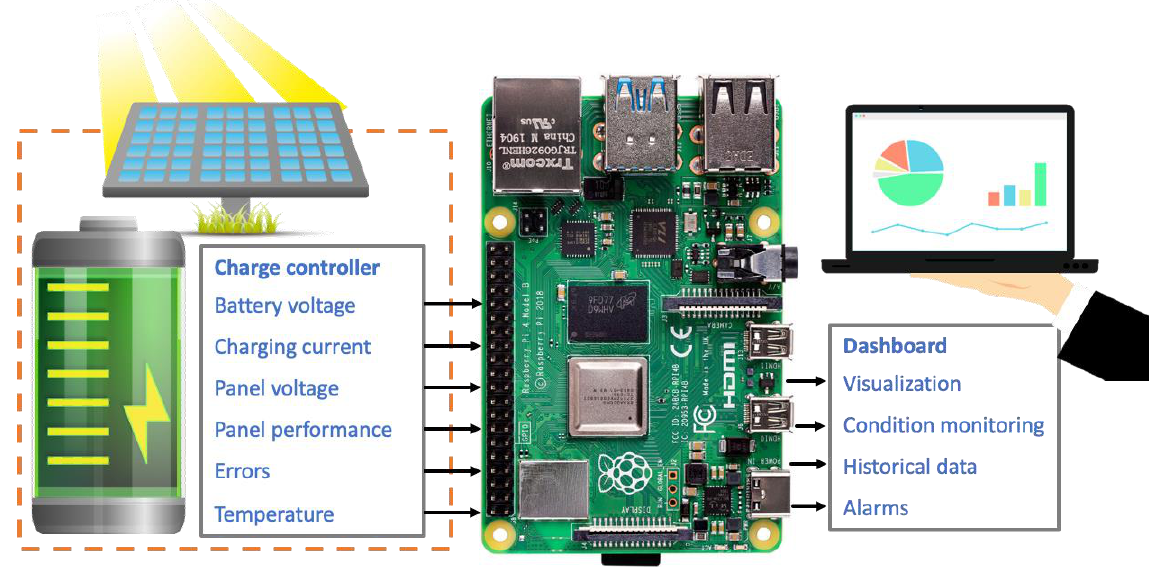
Figure 1 . Architecture of the TCM